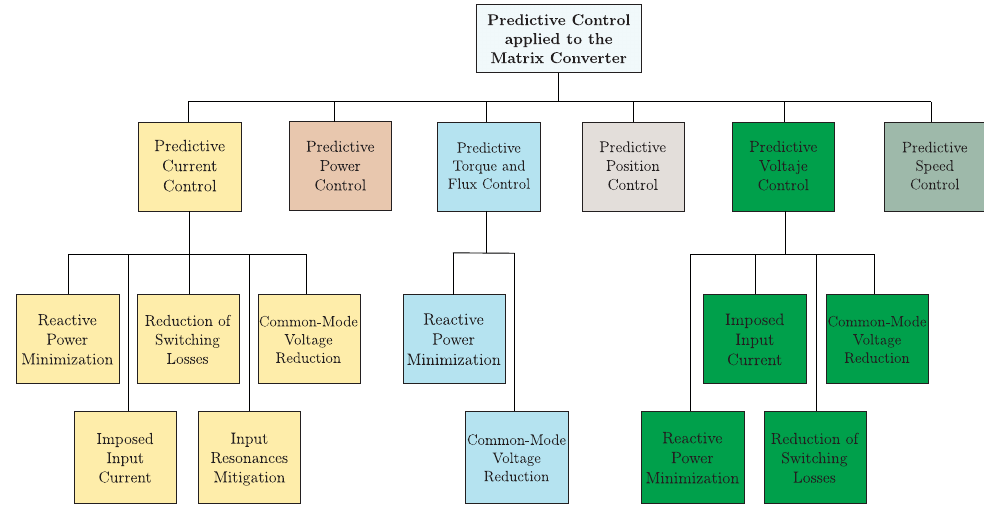
Figure 3. Predictive control techniques applied to matrix converters.